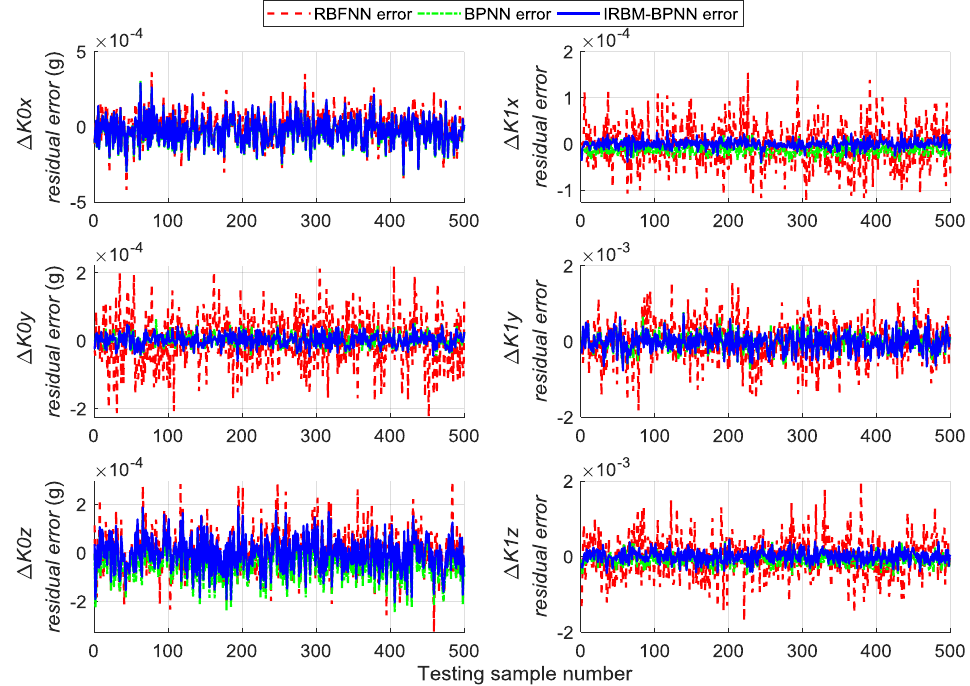
Figure 14. Contrast results of gyroscope residual error using three methods.